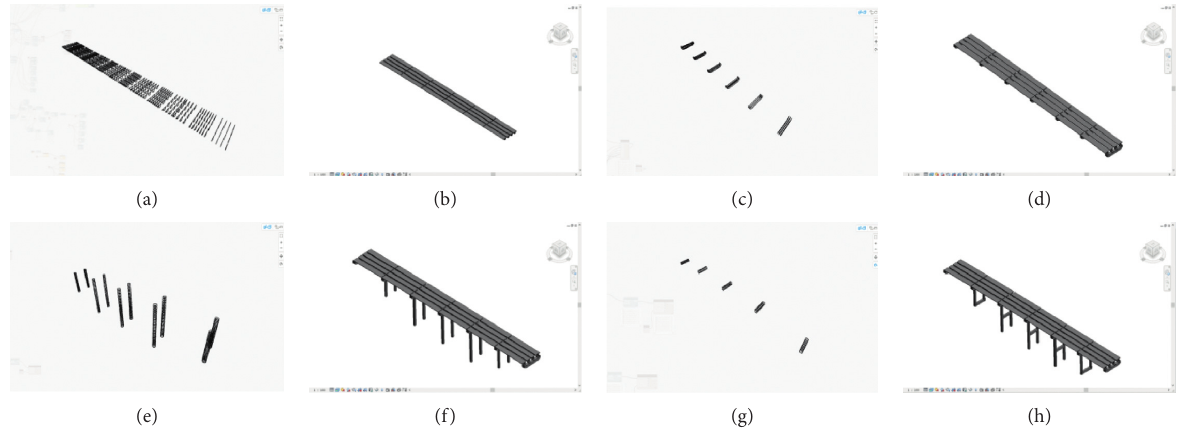
Figure 21: Dynamo drives Revit to complete the process of BIM reconstruction of the construction bridge: (a) feature line of the precast box girder; (b) precast box girder model; (c) capping beam feature line; (d) capping beam model; (e) column feature line; (f) column model; (g) tie beam feature line; (h) tie beam model.